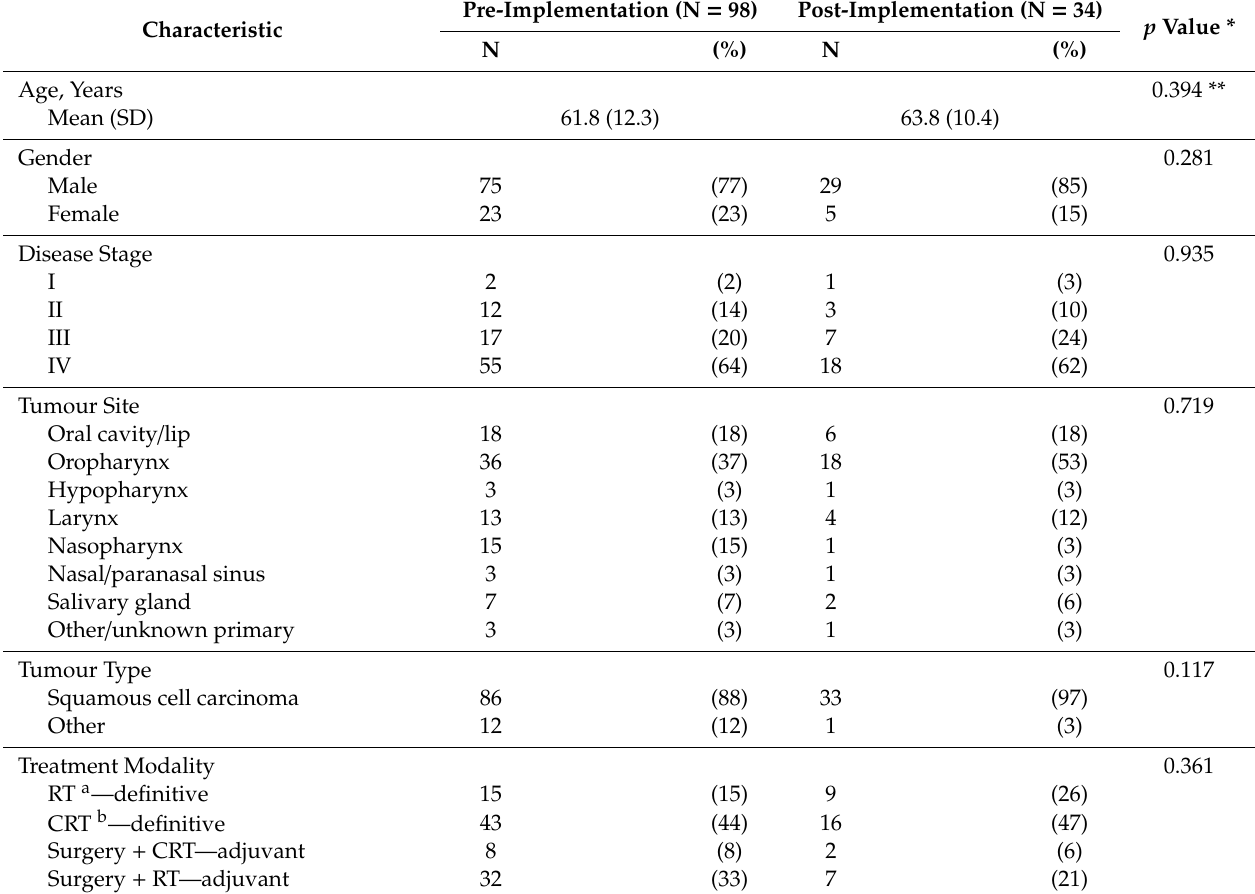
Table 2. Comparison of clinical characteristics between pre- and post-implementation cohorts.